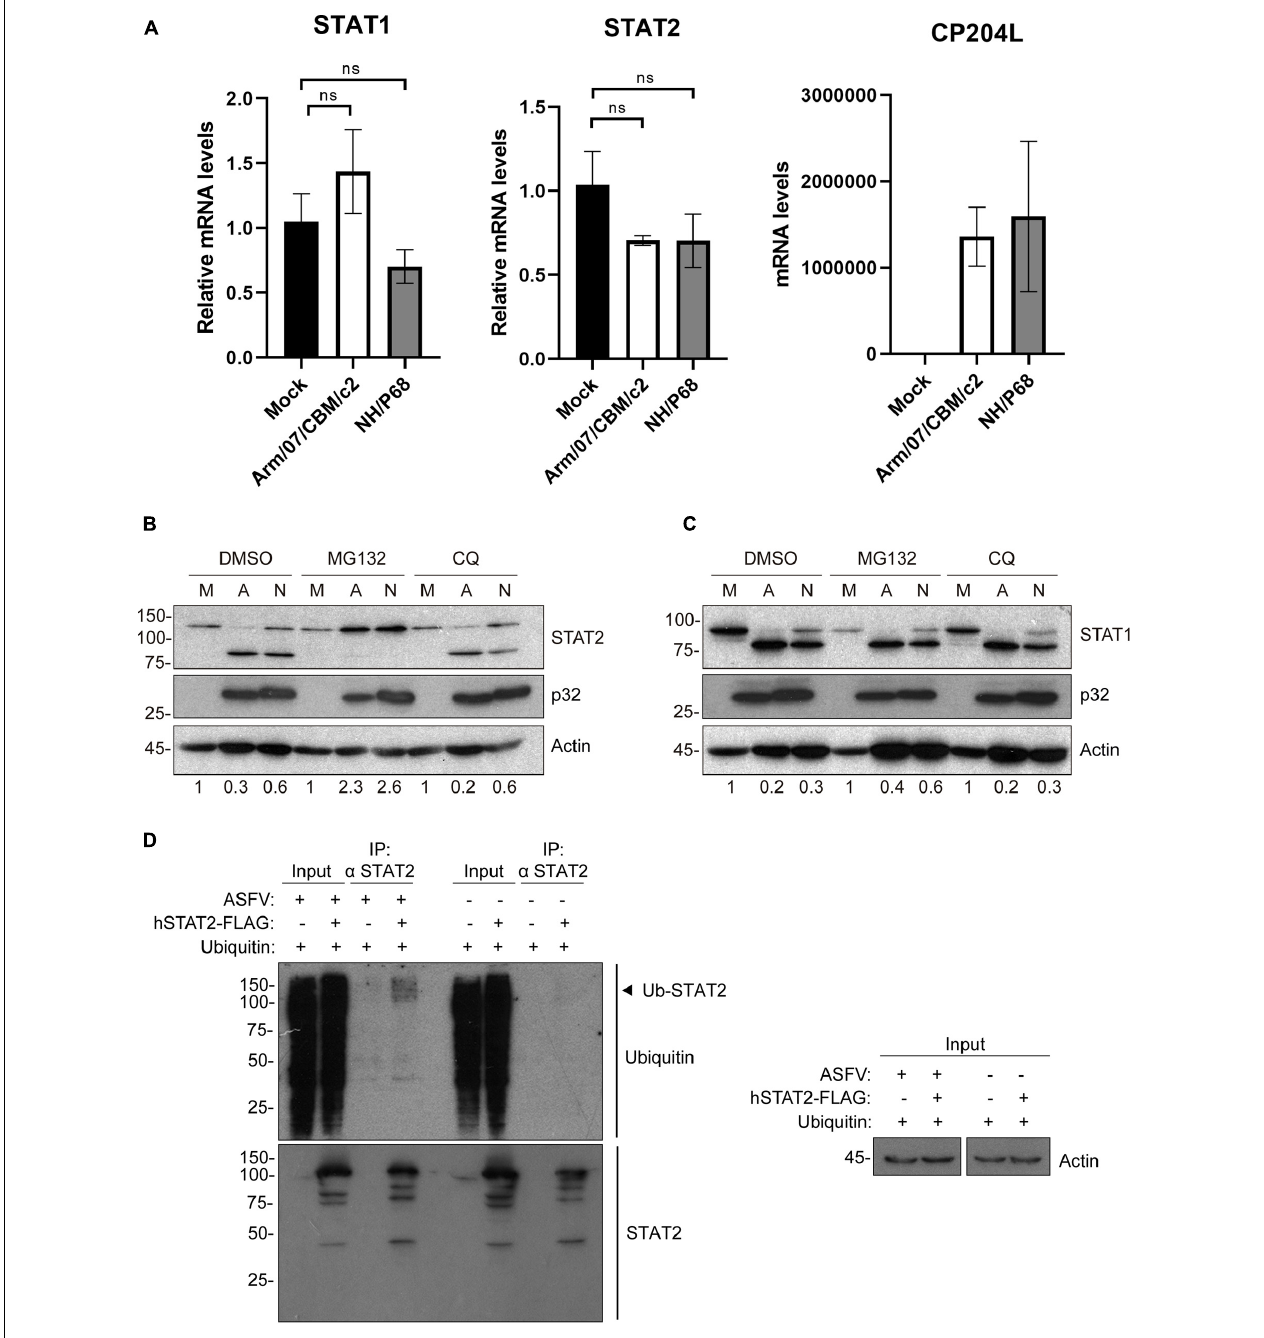
FIGURE 5 | Arm/07/CBM/c2 and NH/P68 infection triggers proteasomal-dependent STAT2 degradation. STAT1 and STAT2 mRNA detection by qRT-PCR (A) . PAMs were mock infected or infected with attenuated NH/P68 or with virulent Arm/07/CBM/c2 ASFV strains (1 PFU/cell). Cells were collected at 3 hpi for a qRT-PCR analysis of STAT1 and STAT2 mRNA levels. As a control of infection, viral p32 mRNA (CP204L) was measured. STAT2 (B) and STAT1 levels (C) were analyzed in presence of the proteasome inhibitor MG132 or the lysosome/autophagosome inhibitor chloroquine (CQ) by Western blot analysis. PAMs were mock infected (M) or infected with Arm/07/CBM/c2 (A) or NH/P68 (N) ASFV strains (3 PFU/cell) and treated with MG132 (20 µ M) or chloroquine (50 µ M) at 12 hpi. At 16 hpi, cells were collected and lysed for the Western blot analysis. The Western blot bands corresponding to STAT1 (91k Da) and STAT2 (113 kDa) were quantified according with their actin levels and relativized with the corresponding mock control using ImageJ. Immunoprecipitation of STAT2 in mock-infected or infected COS-1 cells (D) . COS-1 cells were co-transfected either with pCI-His-hUbiquitin vector and pCAGGS empty vector or hSTAT2-FLAG vector. At 6 h post-transfection cells were infected with Arm/07/CBM/c2 strain (2 PFU/cell). Cells were collected at 16 hpi and lysed for STAT2 immunoprecipitation assay with A/G magnetic beads. Western blot labeling with anti-ubiquitin, anti-STAT2 and anti-actin antibodies is shown. Ubiquitinated STAT2 is indicated with an arrowhead in the figure.